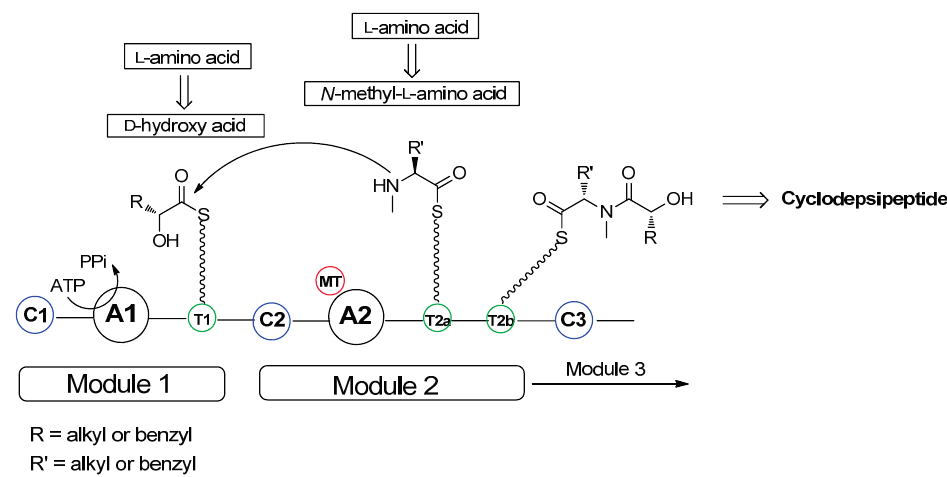
Figure 1. Biosynthesis of NRPs producing